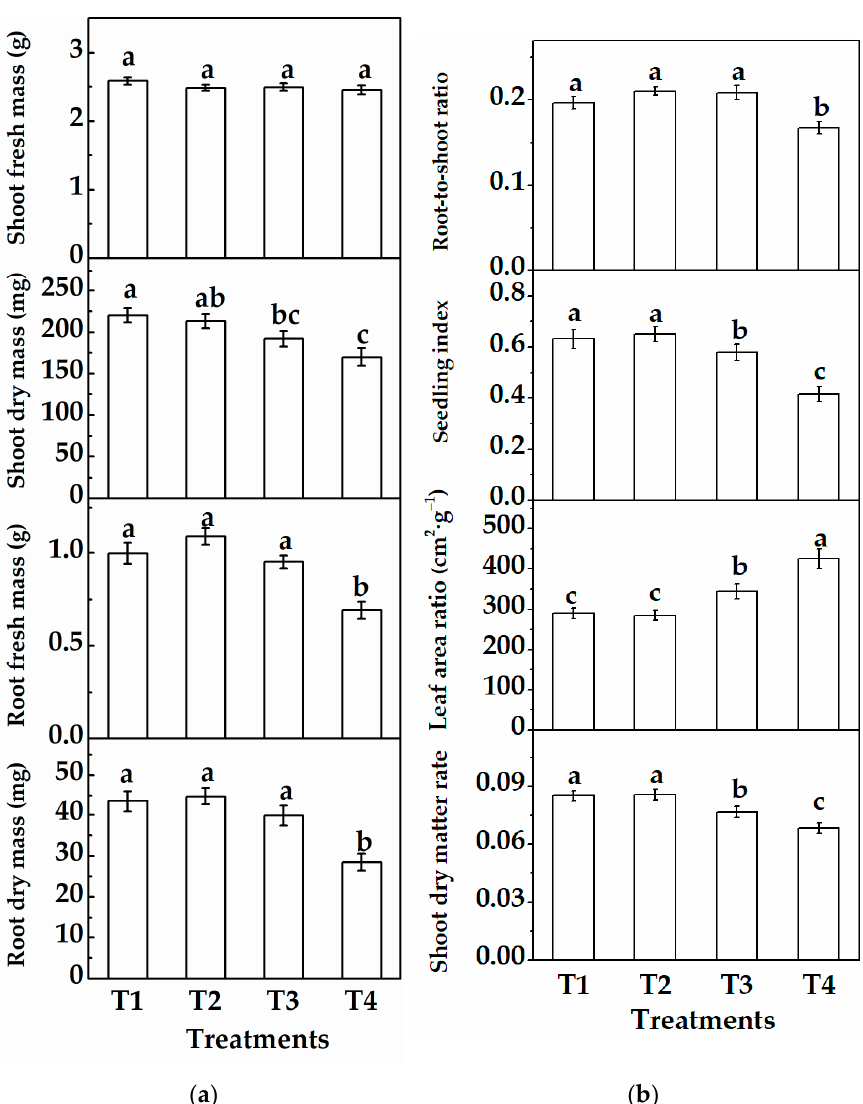
Figure 6. The effects of different light intensities and photoperiods on ( a ) shoot fresh and dry mass, root fresh and dry mass ( b ) root-to-shoot ratio, seedling index, leaf area ratio, and shoot dry matter rate of cucumber seedlings. Different letters indicate statistically significant differences among treatments ( p ≤ 0.05). Error bars show SEs ( n = 18).